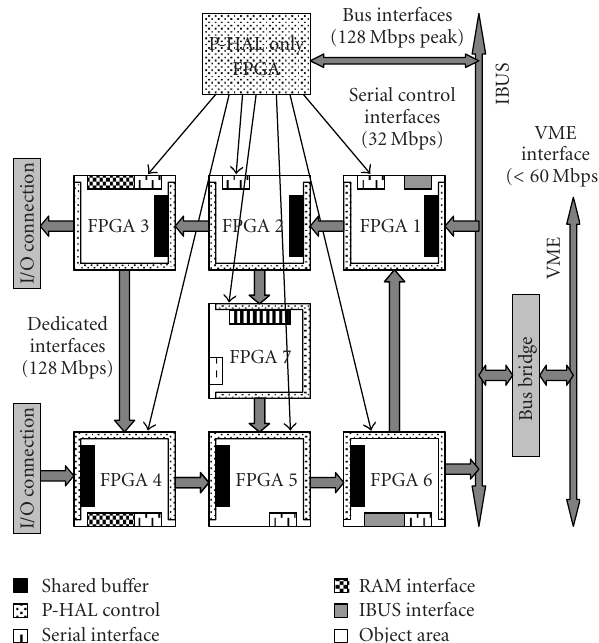
Figure 9: Adjusted P-HAL for SHaRe